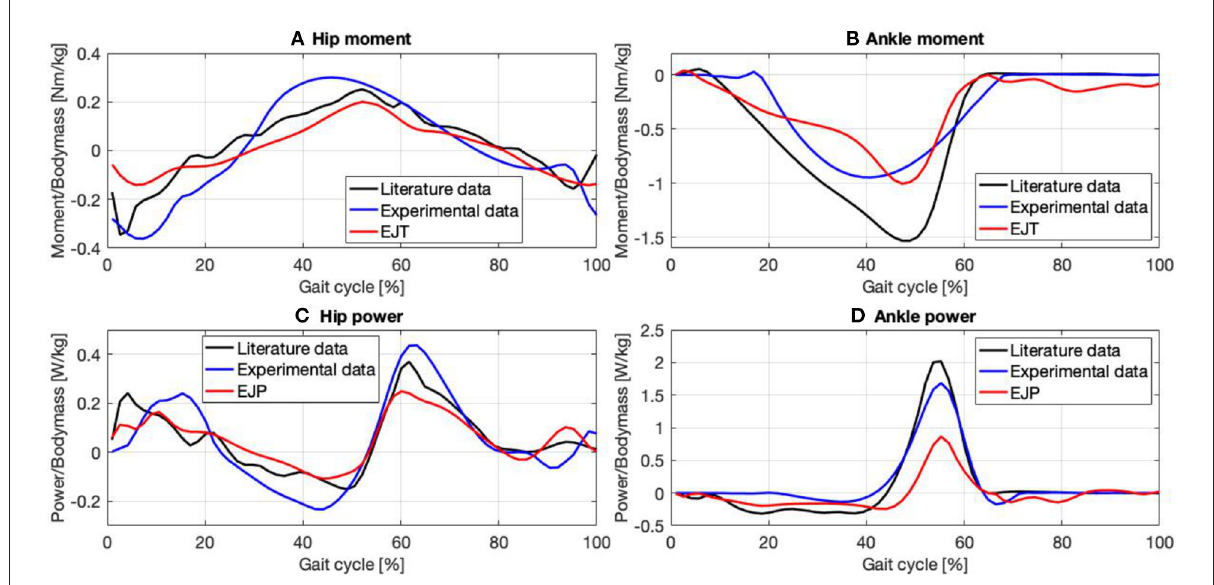
FIGURE4 Joint moment and power for the hip (A,C) and the ankle (B,D) obtained with EMG to force processing (red trend) are compared with data gathered from literature (Winter, 2009) (black trend) and with experimental data obtained using force plates and inverse dynamic (blue